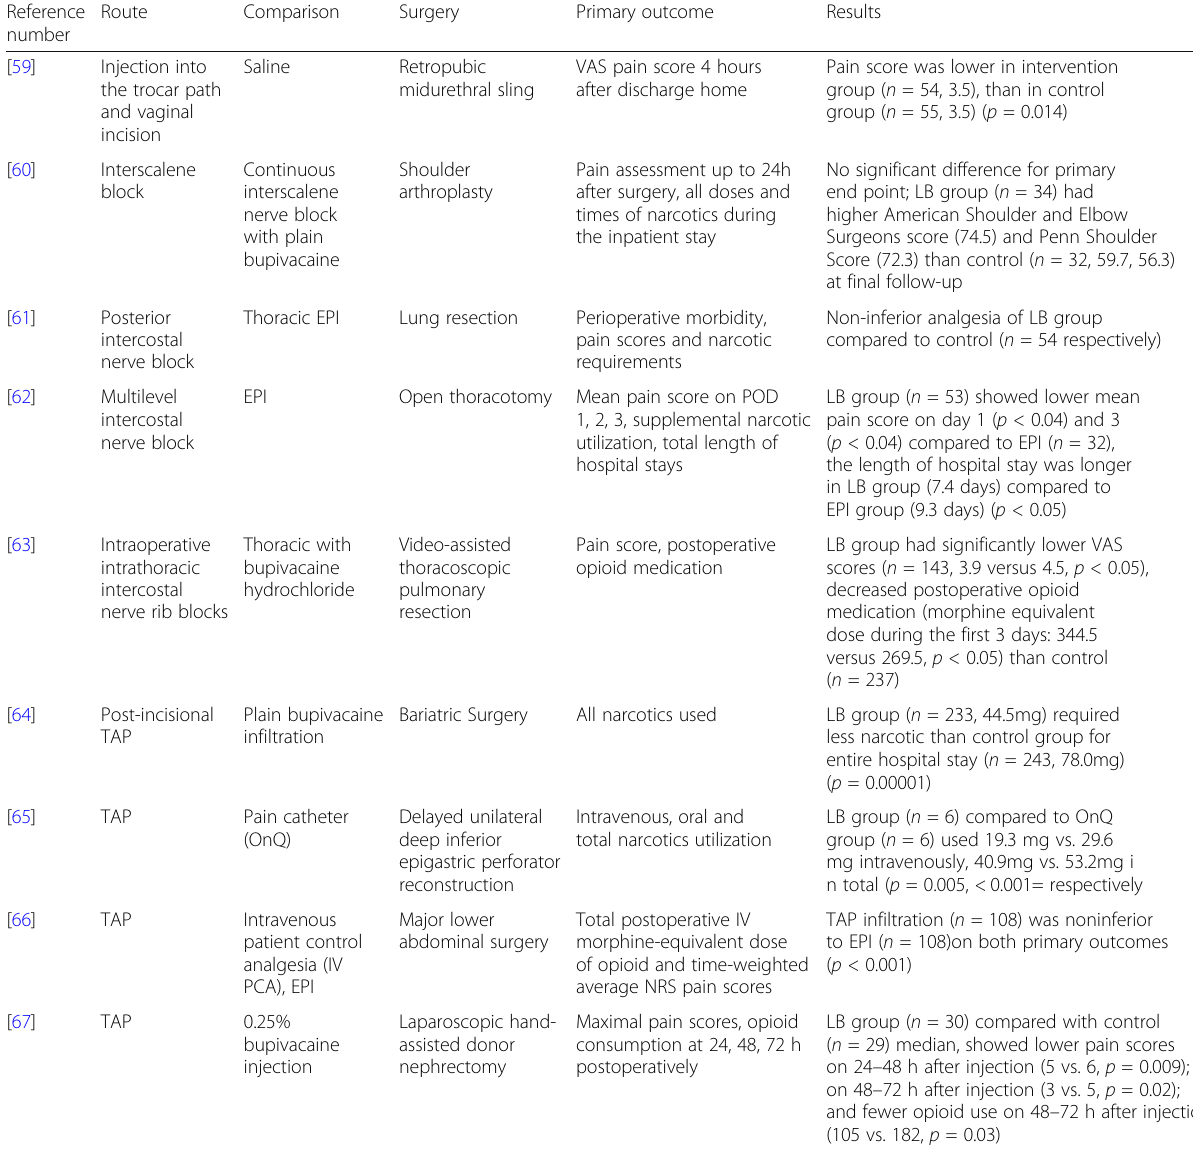
Table 2 Summary of researches with positive efficacy of EXPAREL Reference number